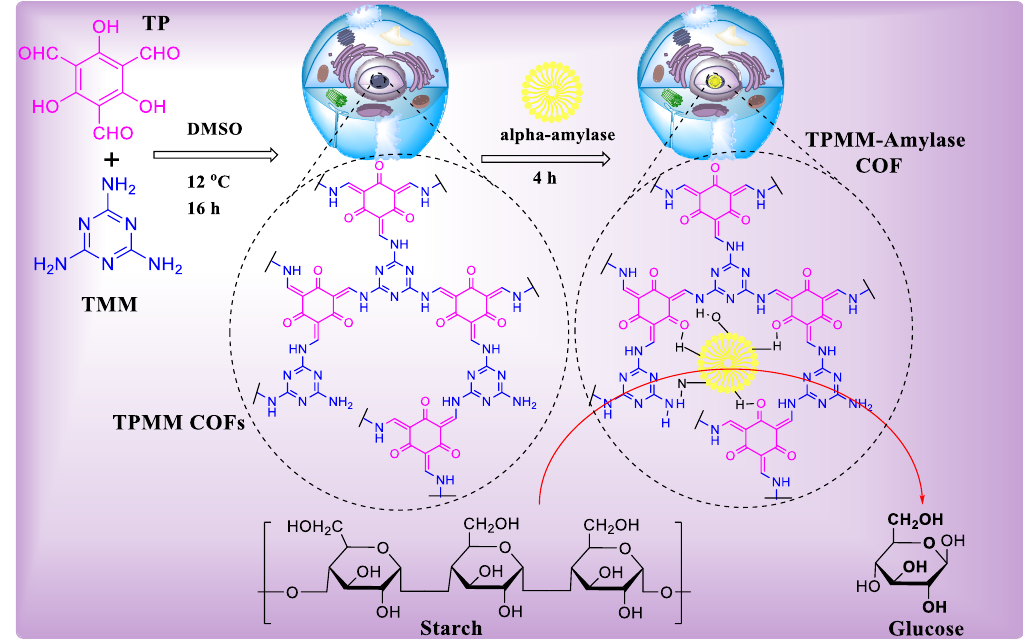
Figure 10. Physical adsorption of a-amylase into the TPMM COF pores “ Reprinted from Integration of α -amylase into covalent organic framework for highly efficient biocatalyst, Samui, A.; Sahu, S.K. Microporous and Mesoporous Materials 2020, 291, 109700. ” Copyright (2022), with permission from Elsevier [126]. Oliveira et al. used COF (PPF-2) and three different strategies to immobilize Candida Antarctica lipase B (CAL-B): (1) physisorption; (2) covalent bonding by the amino group in N-terminal residue of protein and free aldehyde groups of PPF-2-CHO; (3) covalent